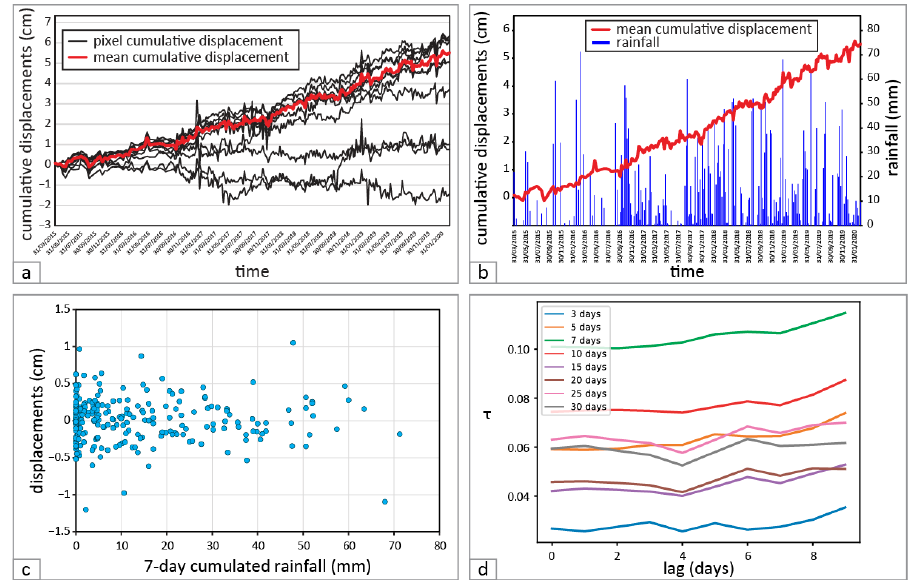
Figure 10. Example of the results obtained for the earth flow (Figure 8), for the T124 descending orbit: ( a ) cumulative displacements measured over the whole observation period (black curves) with the indication of the average displacements representative for the landslide (red curve) defined excluding the three lower paths that have a trend different from the others; ( b ) representative cumulative displacements and 7-day cumulative rainfall; ( c ) scatter plot of the relative displacements and the 7-day cumulative rainfall; ( d ) values of the Kendall coefficient, τ , measuring the ordinal association between rainfall series and relative displacements with different shifts (lag from 0 to 10 days); only the rainfall series that satisfied the hypothesis of p < 0.1 are shown.